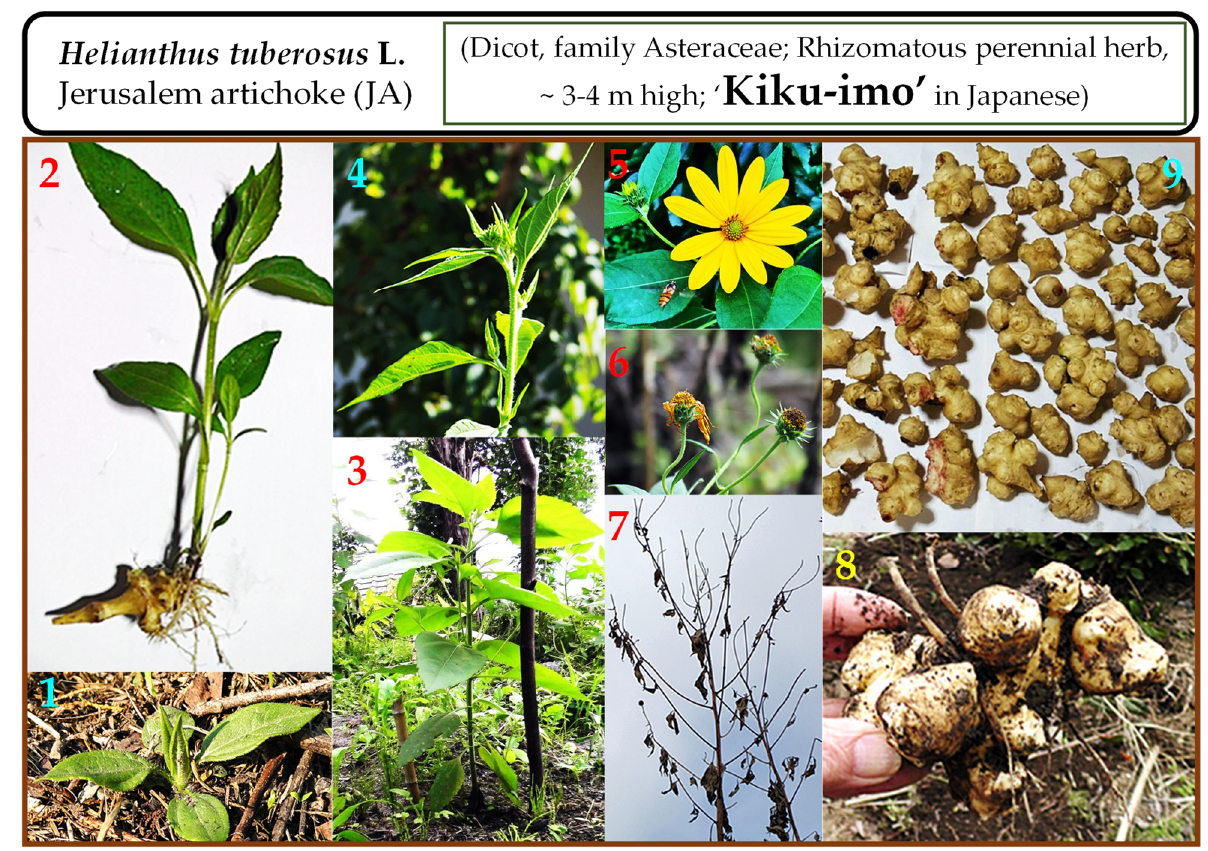
Figure 1. The Helianthus tuberosus L. (Jerusalem artichoke; JA, commonly called ‘Kiku-imo’ in Japanese) plant at different stages of growth: from sprouting till harvesting of the tubers. (1) Sprouting from the soil, (2) Sprout arising from the tuber, (3) Vegetative growth stage, (4) Flowering stage, (5) Flower, (6) Withered flower stage, (7) Wilting plant stage (is where the tubers are ready to be harvested), (8) Freshly dug tubers, and (9) Tubers.